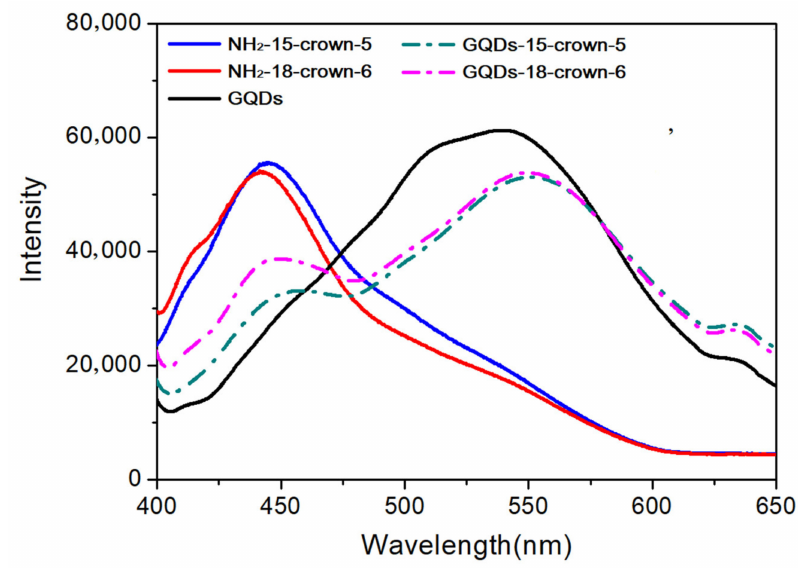
Figure 5. PL spectra of NH 2 -15-crown-5, NH 2 -18-crown-6, GQDs, GQDs-15-crown-5 and GQDs-18- crown-6, at the λ exc of 360 nm. All samples were tested at a concentration of 100